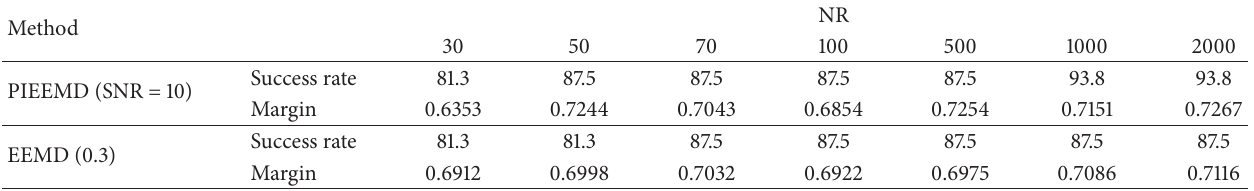
Table 8: The results of using different trial numbers (NR) for the condition: speed = 200 Hz and load = 1.8kN. Method Success rate PIEEMD (SNR = 10)